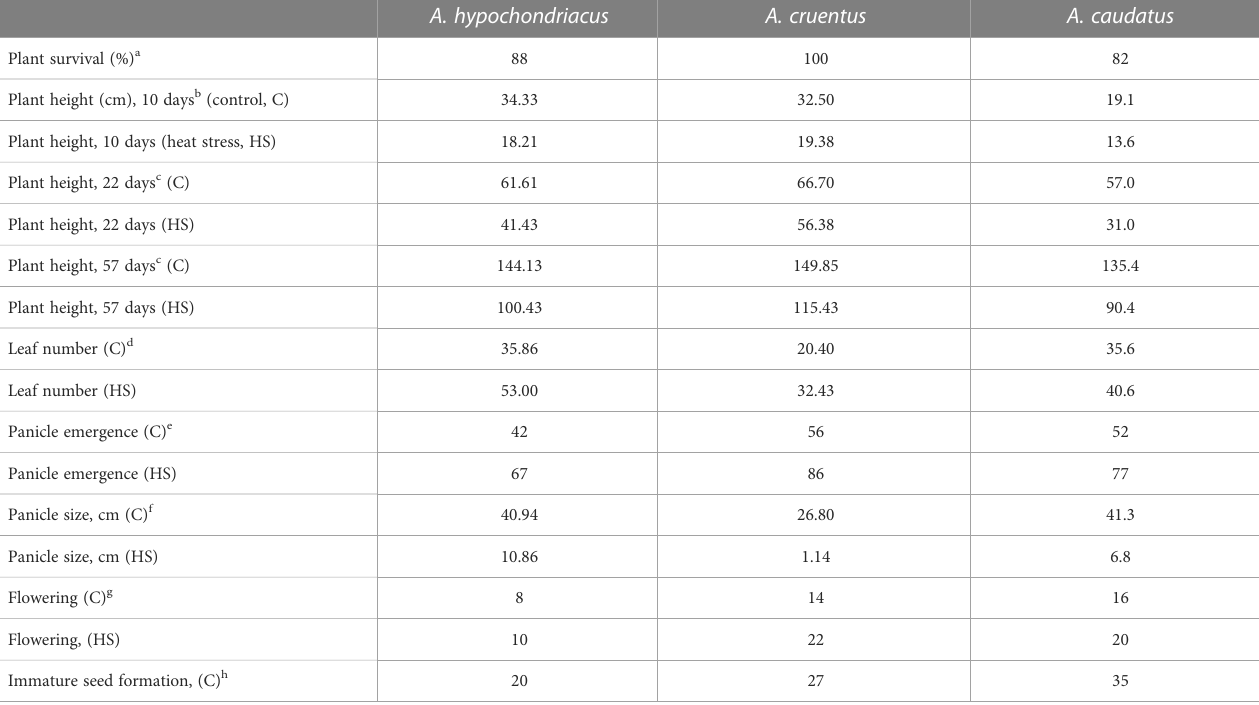
TABLE 2 Effect of extended, severe heat stress on vegetative and reproductive development parameters in grain amaranth species.